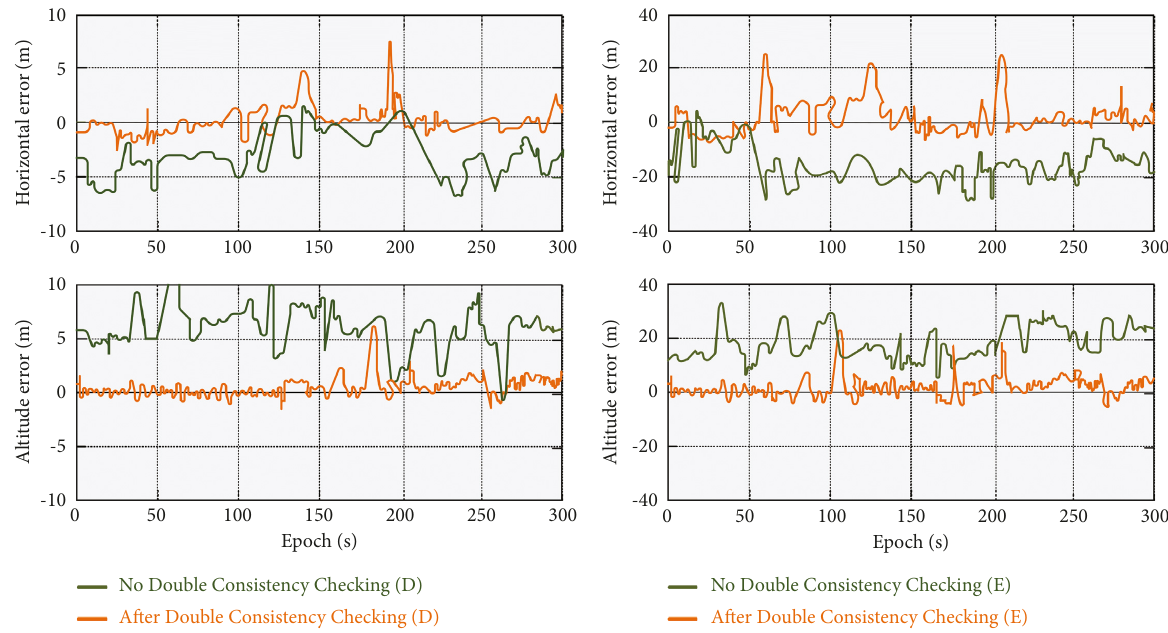
Figure 10: The comparison of positioning errors before and after the application of CC in scene D and E Table 3: Positioning error results for the selected experimental scenarios.